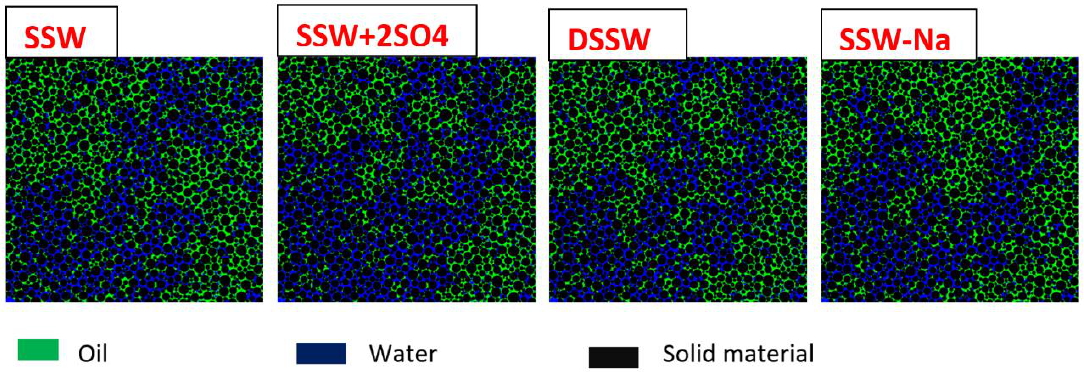
Figure 10. Artificial structure oil-wet micromodels used for injection brines mentioned in Table 2. Figures represent the oil recovery after 10PV injected brine.